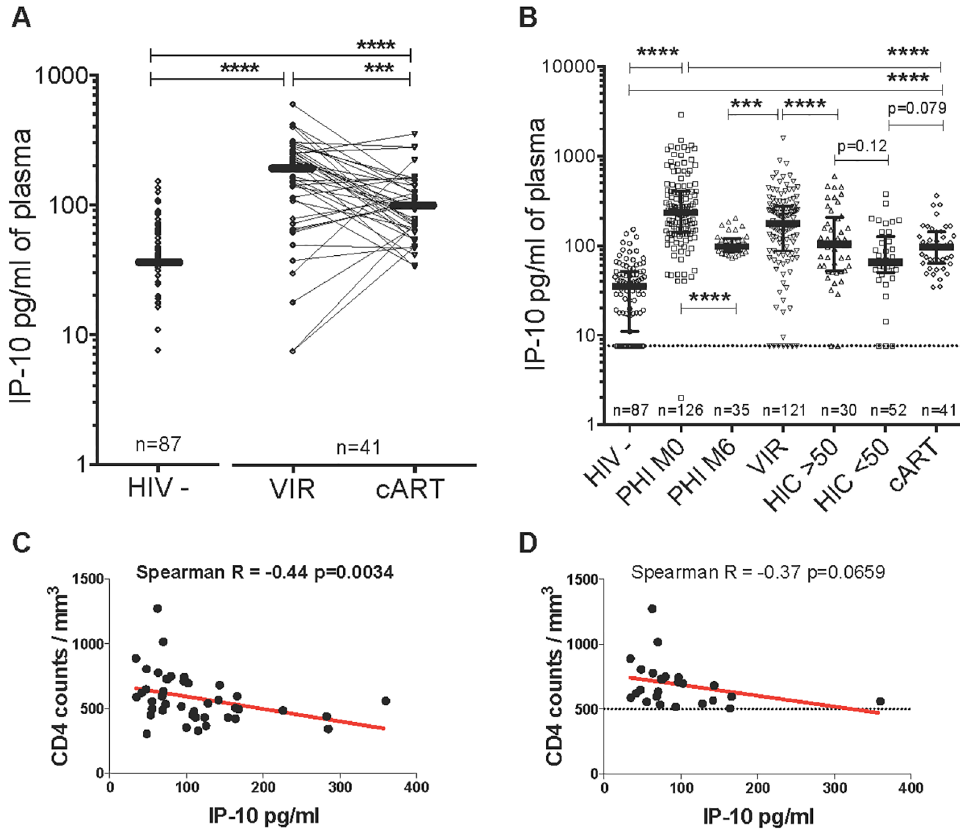
Fig 4. Blood IP-10 levels in patients with controlled HIV viremia. A. IP-10 levels were determined in plasma in a longitudinal study, before treatment initiation and after > 24 months of antiretroviral treatment, in comparison to HIV-negative individuals. The median (IQR) IP-10 values were 35.3 (10.9 – 51.6), 190.2 (78.3 – 269.7) and 97 (63.4 – 141.7) in HIV-, cART-na ï ve (VIR) and cART-treated individuals, respectively. IP-10 levels fell in cART- treated patients. B. Comparison of IP-10 levels during primary (PHI), post-acute (M6) and chronic HIV-1 infection (HIC, VIR) by comparison with cART-treated patients. HIC < 50 and HIC > 50 respectively represent HIV controllers with HIV RNA < and > 50 copy numbers/ml. C. Correlation between plasma IP-10 levels and CD4 cell counts during treatment. D. Correlation between plasma IP-10 levels and CD4 counts during treatment, considering only individuals with CD4 > 500 (25 patients). BL = baseline levels before antiretroviral treatment, cART = combination antiretroviral treatment, HIV- = HIV negative, PHI M0 = Primary HIV-1 infection time of enrollment in the PRIMO cohort, M6 = 6 months post M0/PHI, VIR = viremic cART-na ï ve patients, HIC = HIV controllers, *** p < 0.0001, **** p < 0.00001. n = number of